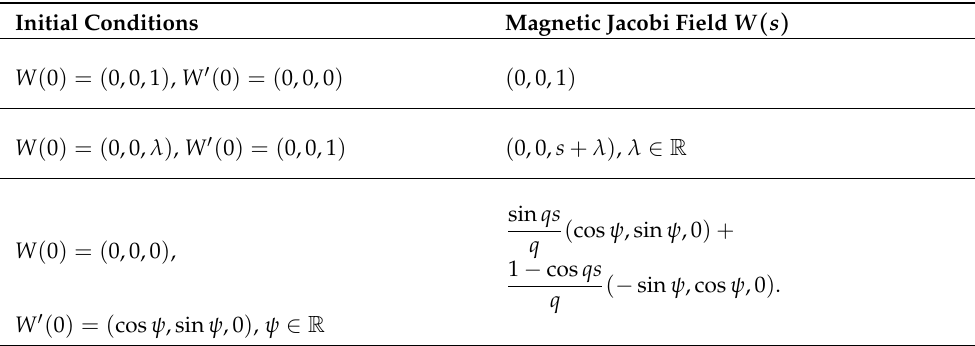
Table 1. Examples of magnetic Jacobi fields in E 3